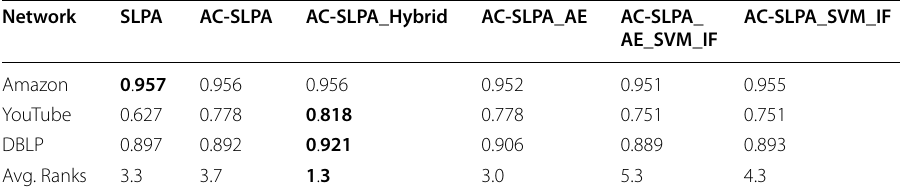
Table 19 Average NMI scores of AC-SLPA using different cleaning methods (Hybrid, AE, AE_SVM_IF, and SVM_IF), SLPA and AC-SLPA with noisy pairwise constraints on three real- world networks. Average ranks across the networks are also reported